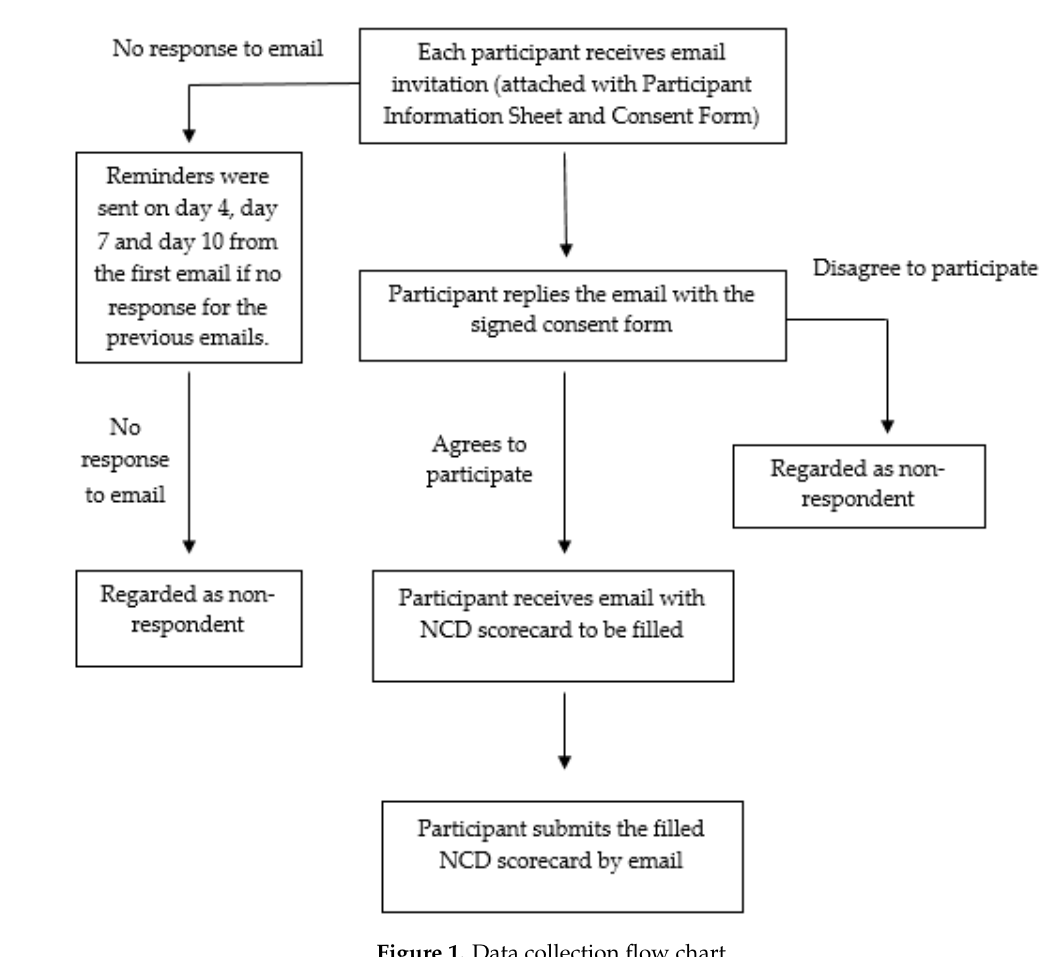
Figure 1. Data collection flow chart.